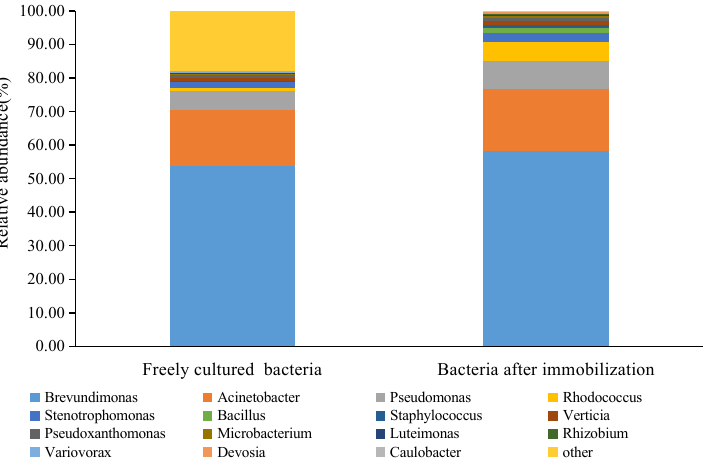
Figure 5. Changes in the bacterial composition and abundance after immobilization.